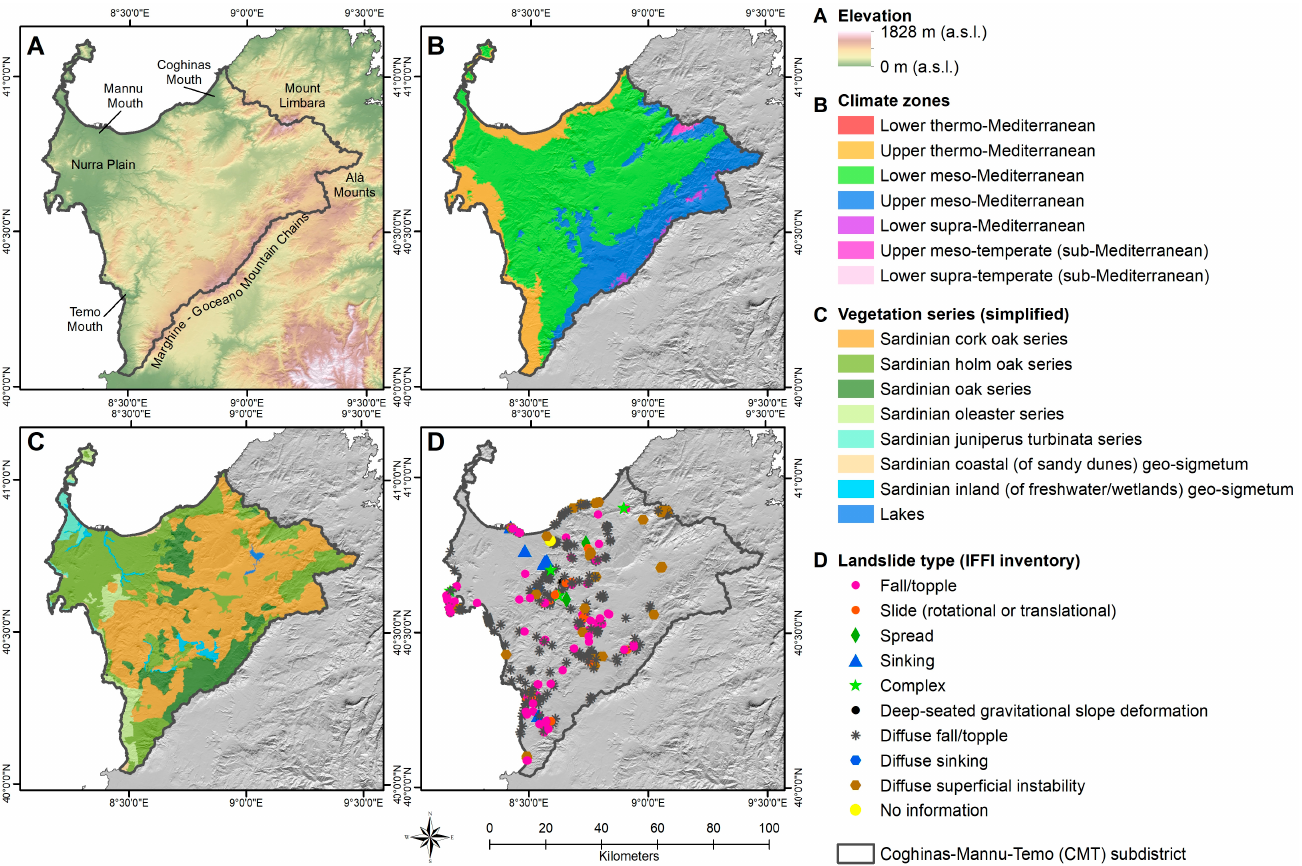
Figure 2. Some features of the Coghinas-Mannu-Temo subdistrict: elevation (panel A ); climate zones (panel B , based on [38]); simplified vegetation series (panel C , based on [39]); documented landslides events (panel D , based on data from the IFFI project [40]).